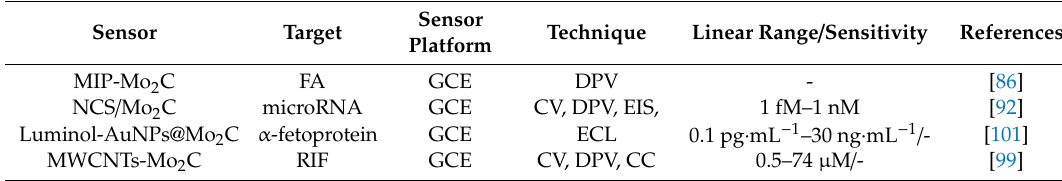
Table 3. 2D Mo-carbide